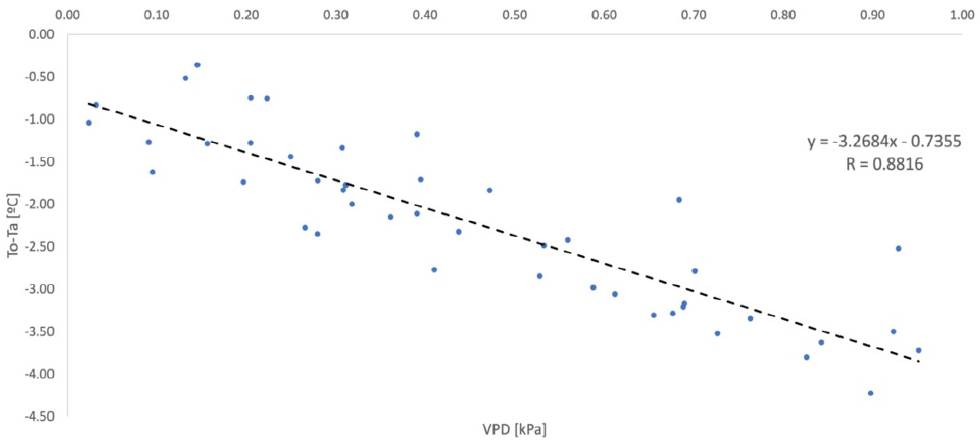
Figure 7. Non-Water-Stressed Baseline Parameterization defined for the unprotected environment (NWSB D ). Vapor Pressure Deficit (VPD). (NWSB D ). Vapor Pressure Deficit (VPD).